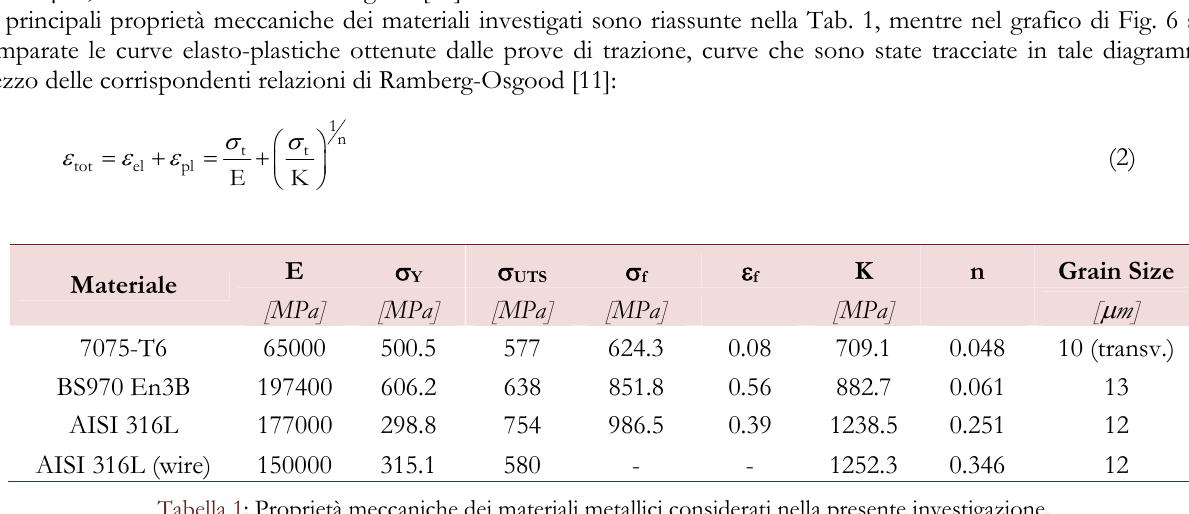
Table 1: Mechanical properties of the investigated metallic